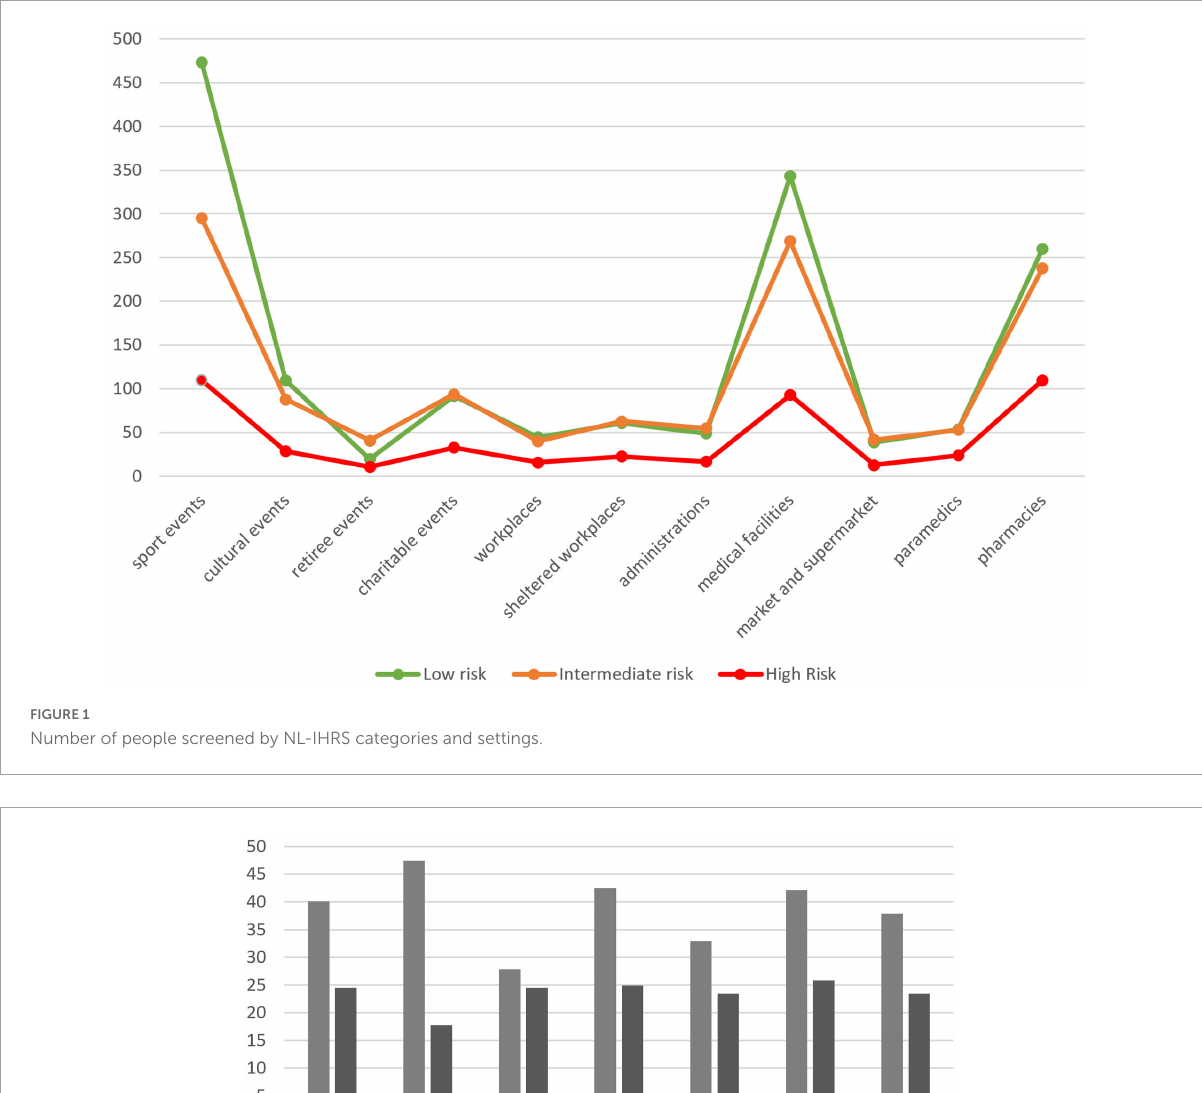
FIGURE2 Declared levels of stress and